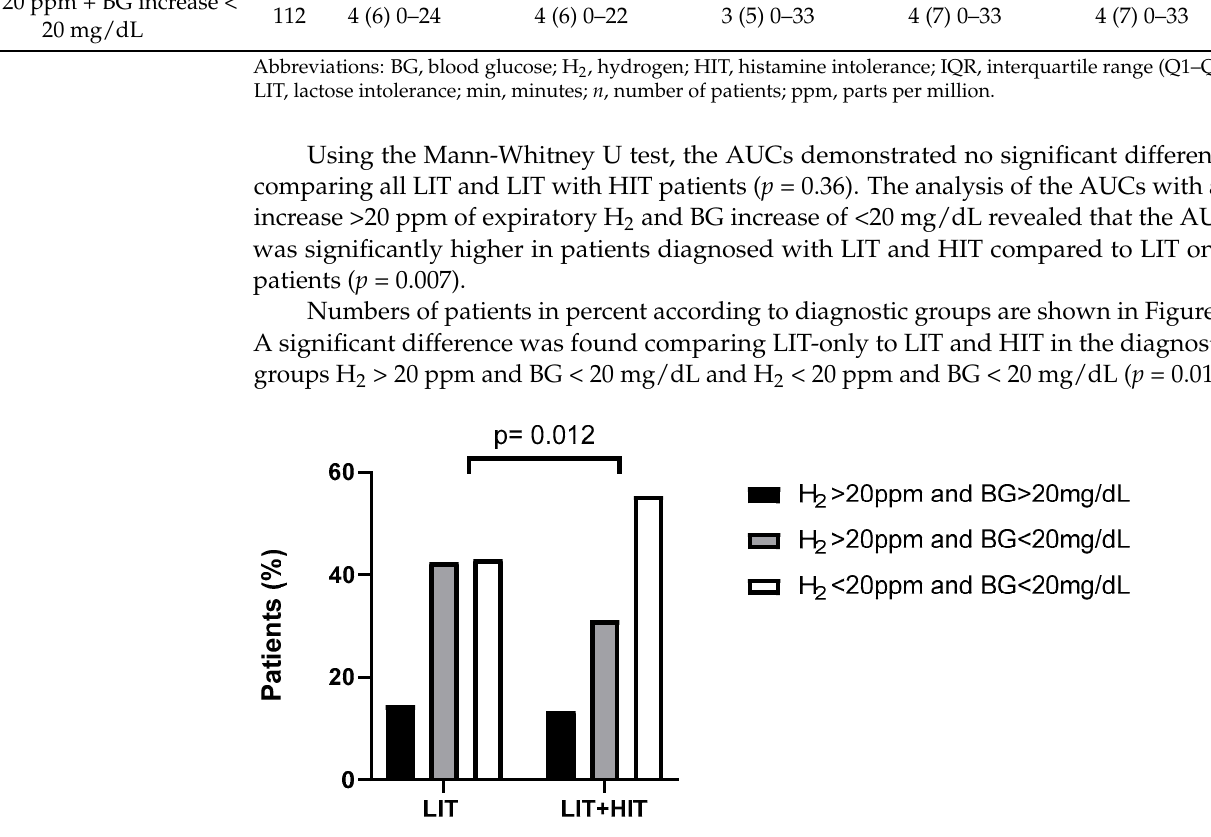
Figure 1. Numbers of patients in percent (%). Included are 402 patients, consisting of 200 LIT-only patients and 202-LIT patients with additional HIT. Abbreviations: BG, blood glucose; H 2 , hydrogen; HIT, histamine intolerance; LIT, lactose intolerance; ppm, parts per million. Patients indicated their symptoms during the breath tests on paper. GI symptoms included bloating, abdominal pain, stomach rumbling, diarrhea, fullness, belching